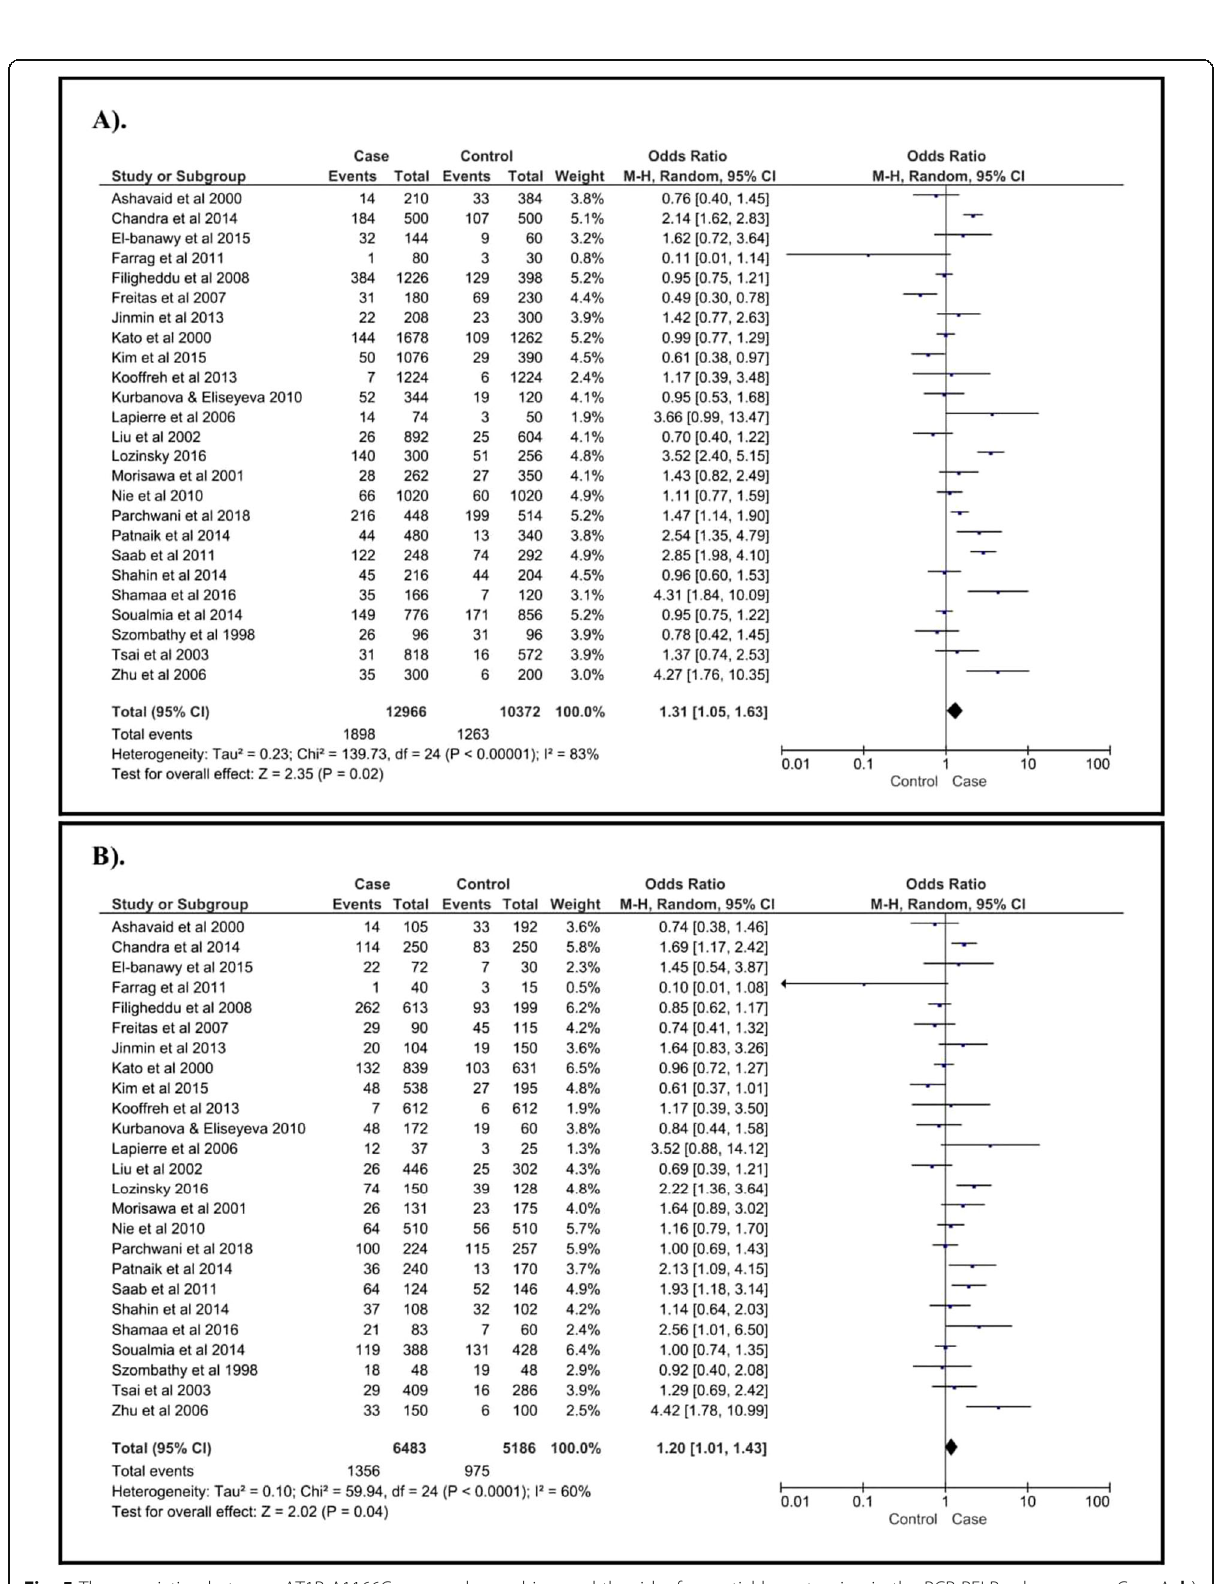
Fig. 5 The association between AT1R A1166C gene polymorphism and the risk of essential hypertension in the PCR-RFLP sub-group. a . C vs. A, b ) AC vs. AA +